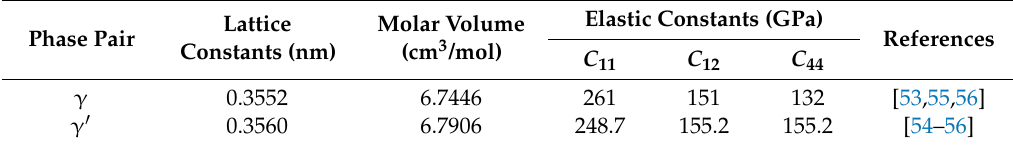
Table 2. Lattice parameters, molar volume and elastic constants adopted in the present simulations. Phase